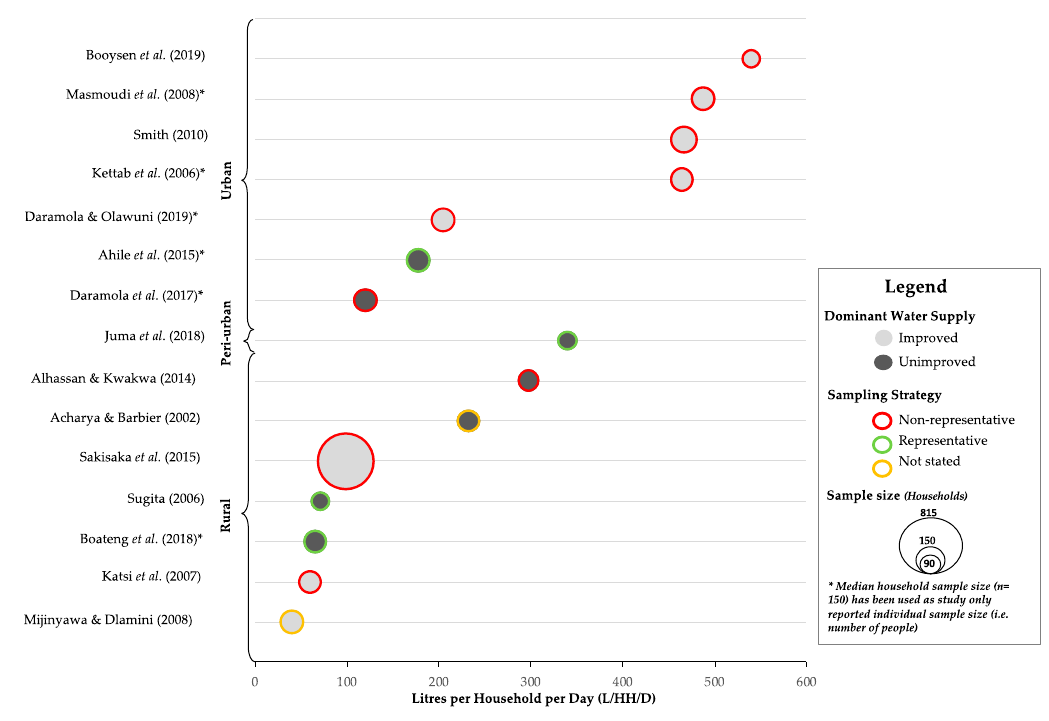
Figure 4. Daily household drinking water availability, based on dominant household supplies